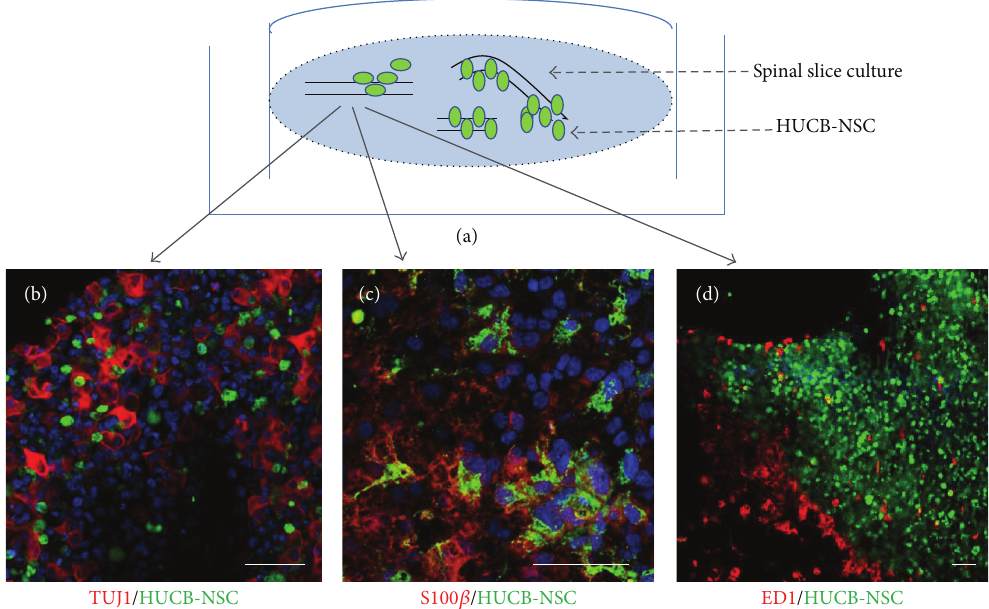
Figure 2: Direct transplantation of HUCB-NSC into the spinal cord organotypic slice culture, an example of immunohistochemistry experiment. The cells were traced with CMFDA for their identification after engraftment. The transplanted cells (green) migrated inside the slice and spread out between the host neurons ((b); TUJ1, red). Three weeks after transplantation part of the transplanted cells expressed the astrocyte marker S100 𝛽 ((c); red). The local immune response to xenografts was moderate ((d); ED1, red). Cell nuclei (blue) were stained with Hoechst 33258. Scale bar is 50 𝜇